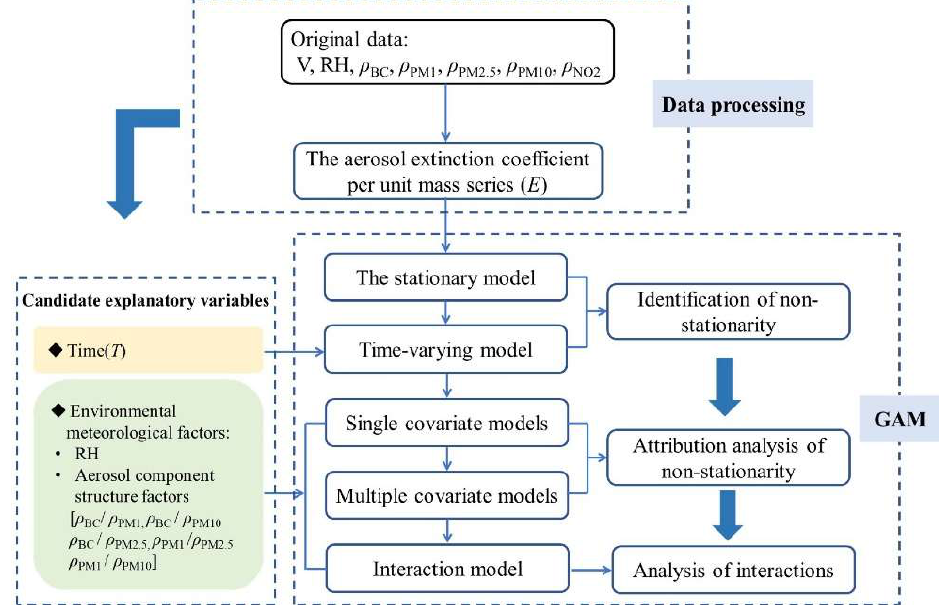
Figure 3. The framework of non-stationarity analysis of the aerosol extinction coefficient per unit of mass.